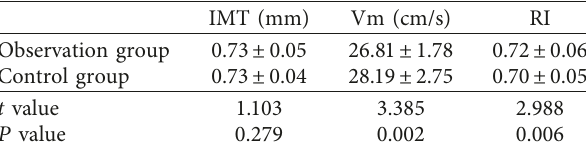
Table 4: IMT and hemodynamic parameters of the